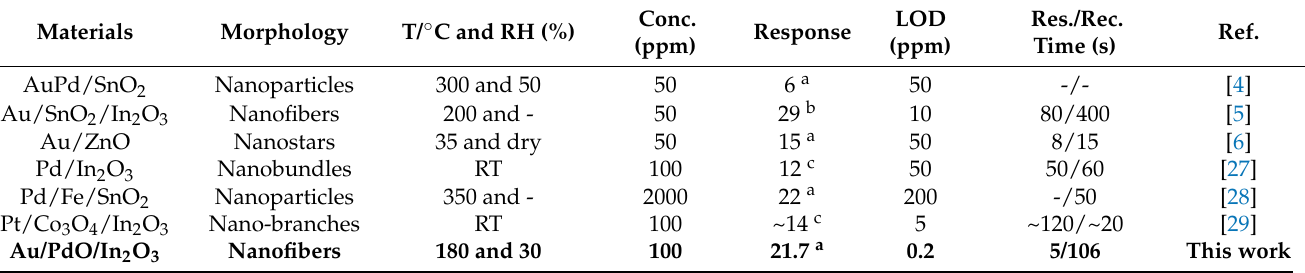
Table 3. Comparison of different gas sensors for detecting CO.